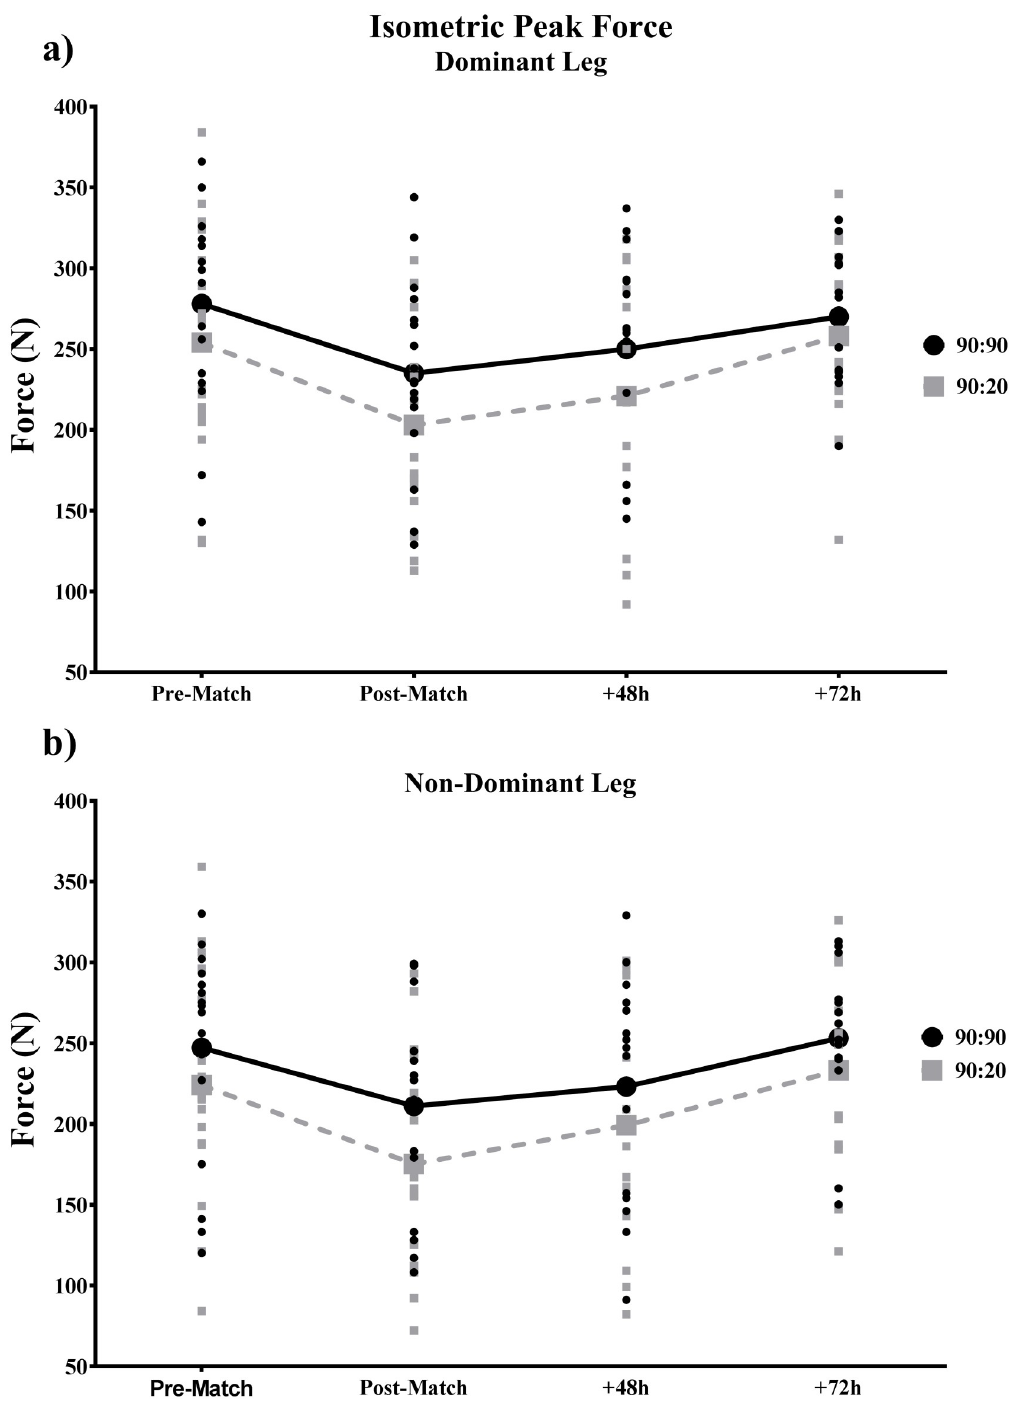
Fig 5. Isometric posterior chain peak force pre, immediately post, +48h and + 72h post a simulated soccer match (BEAST90 mod ) assessed with the supine 90:90 and the standing 90:20 tests (a) in the dominant leg (b) in the non- dominant leg. Thick and dotted lines represent mean values. Single data points represent individual scores for each player.